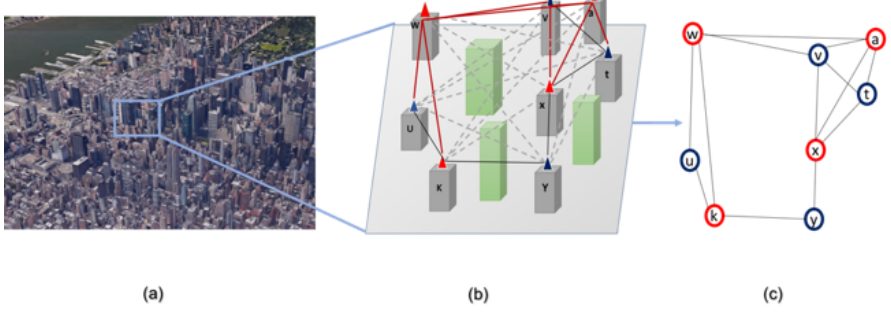
Figure 3. A simple visibility graph that displays a terrain with a set of (green and gray) buildings: ( a ) an example of buildings in a “real” city map; ( b ) an enlarged part of the map, where the red lines represent FSO links between two buildings, and the gray dashed lines are non-FSO links; and ( c ) the red-–blue visibility graph of the terrain, where each point in the graph corresponds to a